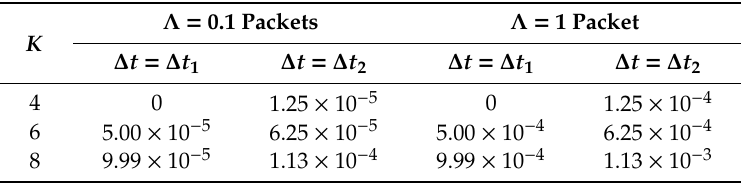
Table 1. P sc for L = 1